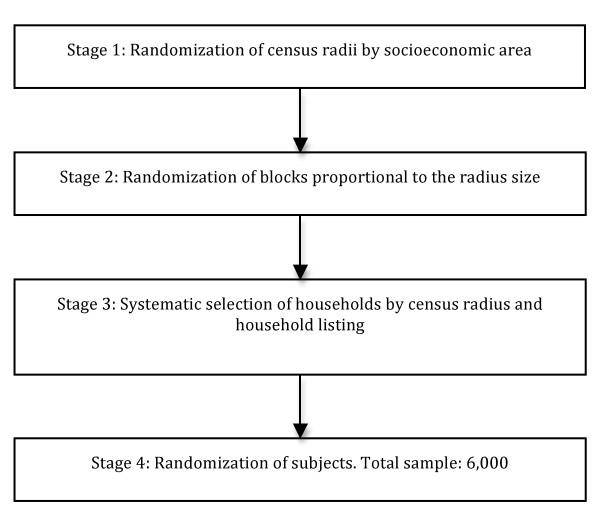
Sampling procedure.